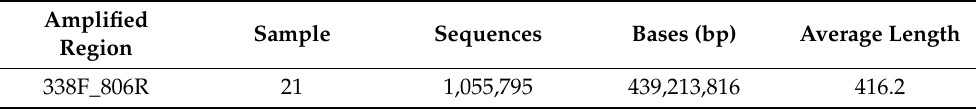
Table 2. The optimized sequence information obtained via bacterial high-throughput